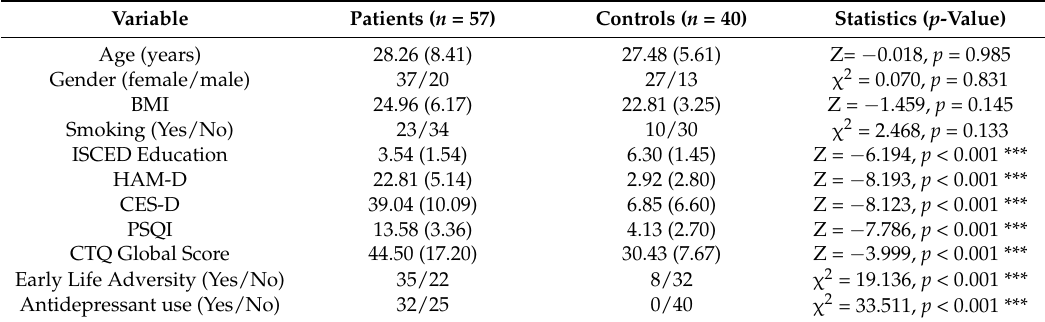
Table 1. Demographic data for patients with Major Depressive Disorder (MDD) and healthy controls for whom salivary cortisol and cortisone was measured by liquid chromatography-mass spectrometry (LC-MS).